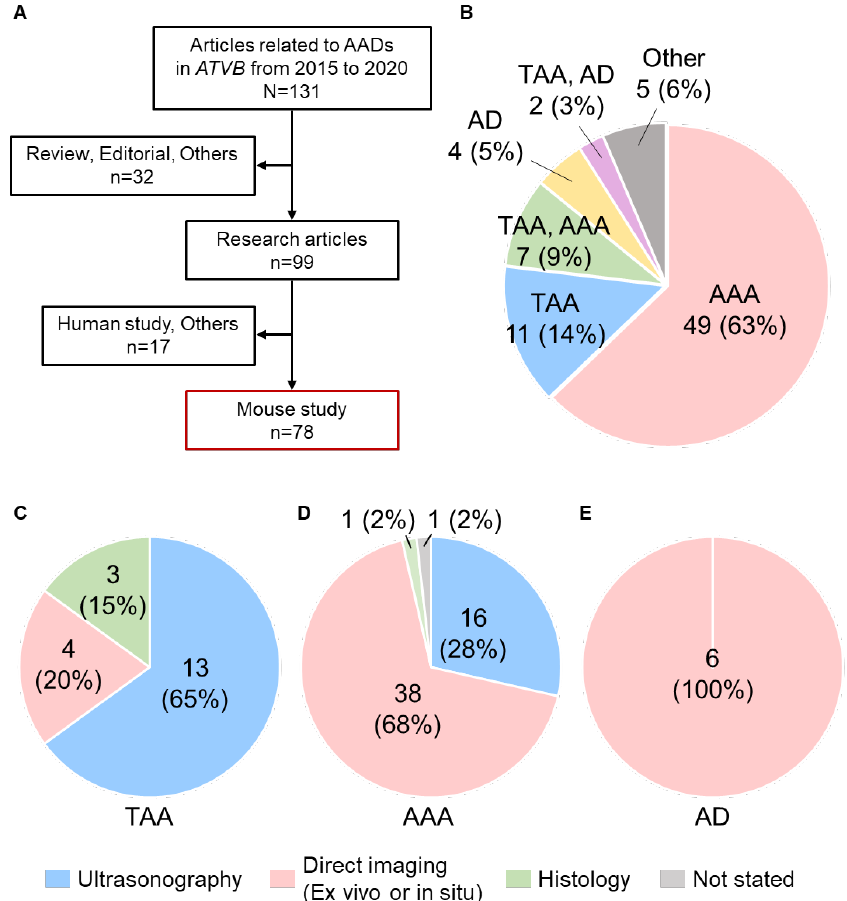
Figure 1. Difference of the primary imaging approach in mouse studies for aortic diseases published in Arteriosclerosis, Thrombosis, and Vascular Biology ( ATVB ) from 2015 to 2020. ( A ) Schematic diagram for included or excluded articles in this review. ( B ) The number of articles of aortic studies published in ATVB from 2015 to 2020. Primary imaging approaches for the evaluation of ( C ) TAA, ( D ) AAA, and ( E ) AD.